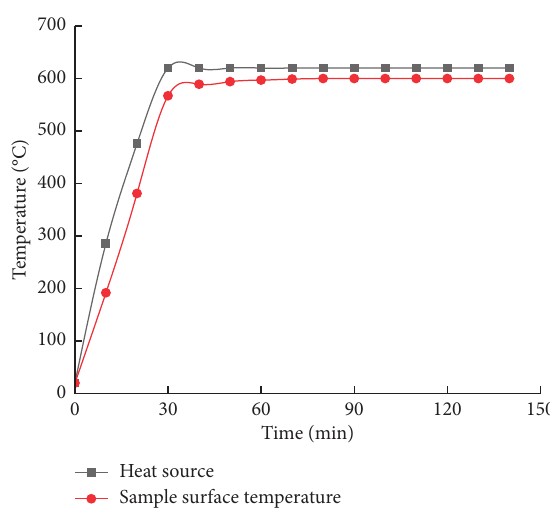
Figure 3: The temperature relationship between heater and sample